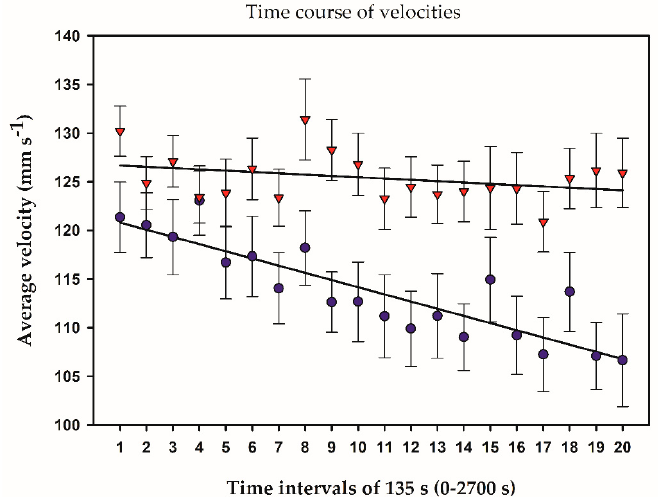
Figure 1. Average velocity of unexposed male zebrafish in spawning (- ▼ -) and non-spawning (- ● -) pairs during the 45 min recording. Average velocities were categorized into 20 intervals of 135 s. As evident from the regression lines, males in spawning pairs maintained a nearly constant average velocity, whereas males in non-spawning pairs gradually reduced their average velocity. Error bars represent SEM.